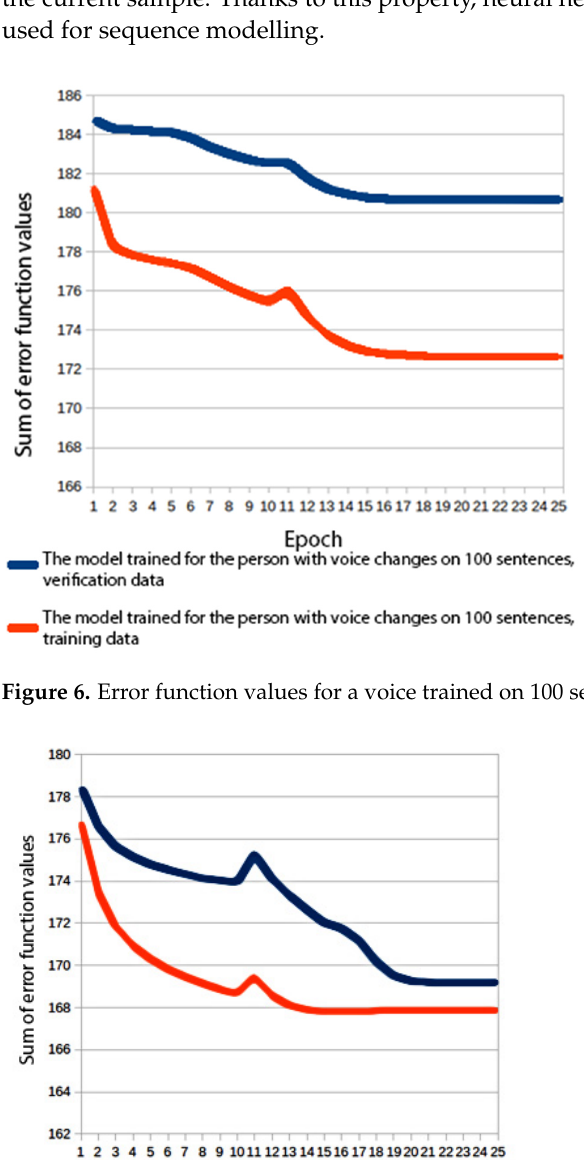
Figure 7. Error function values for a voice trained on 2000 sentences.